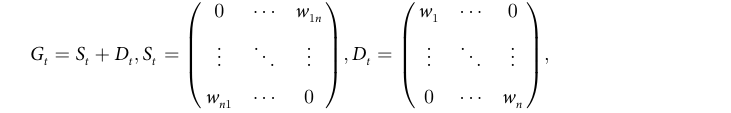
DSCN algorithm consists of six steps ( Fig 1 ):